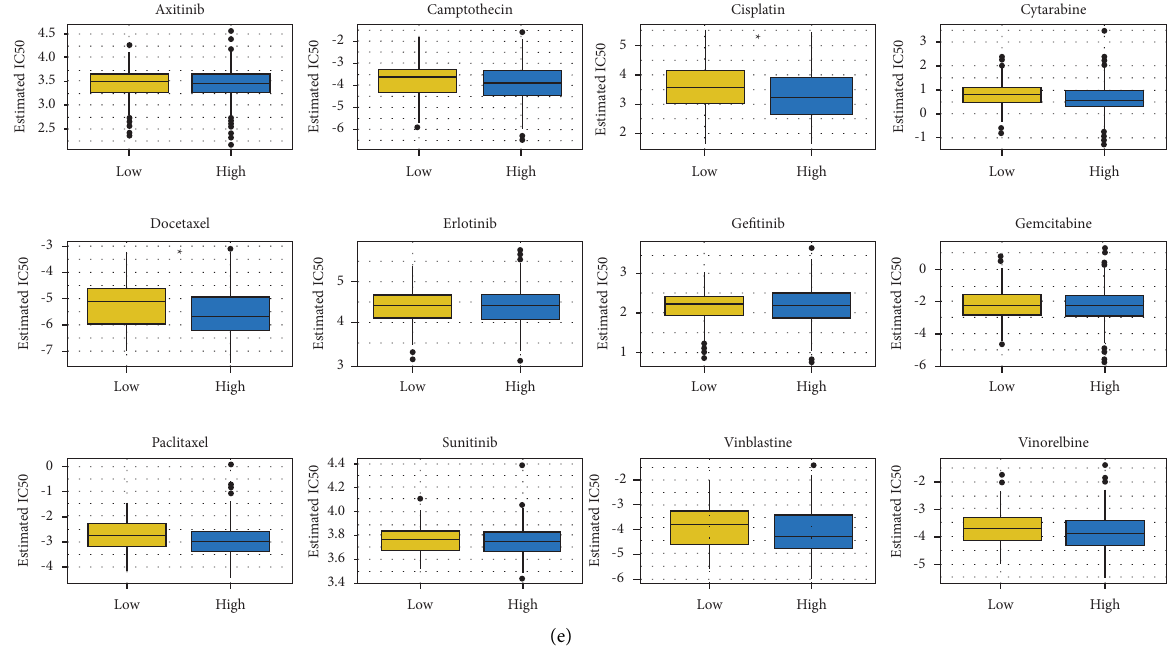
Figure 5: Immunotherapy and chemotherapy sensitivity. (a) Te TIDE algorithm was used to evaluate the response of lung cancer patients on immunotherapy; (b) correlation between risk score and TIDE score; (c and d) low-risk patients had a lower TIDE score and a high percentage of immunotherapy responders, ∗ � P < 0 . 05; (e) chemotherapy sensitivity diference between high- and low-risk patients, ∗ � P < 0 .